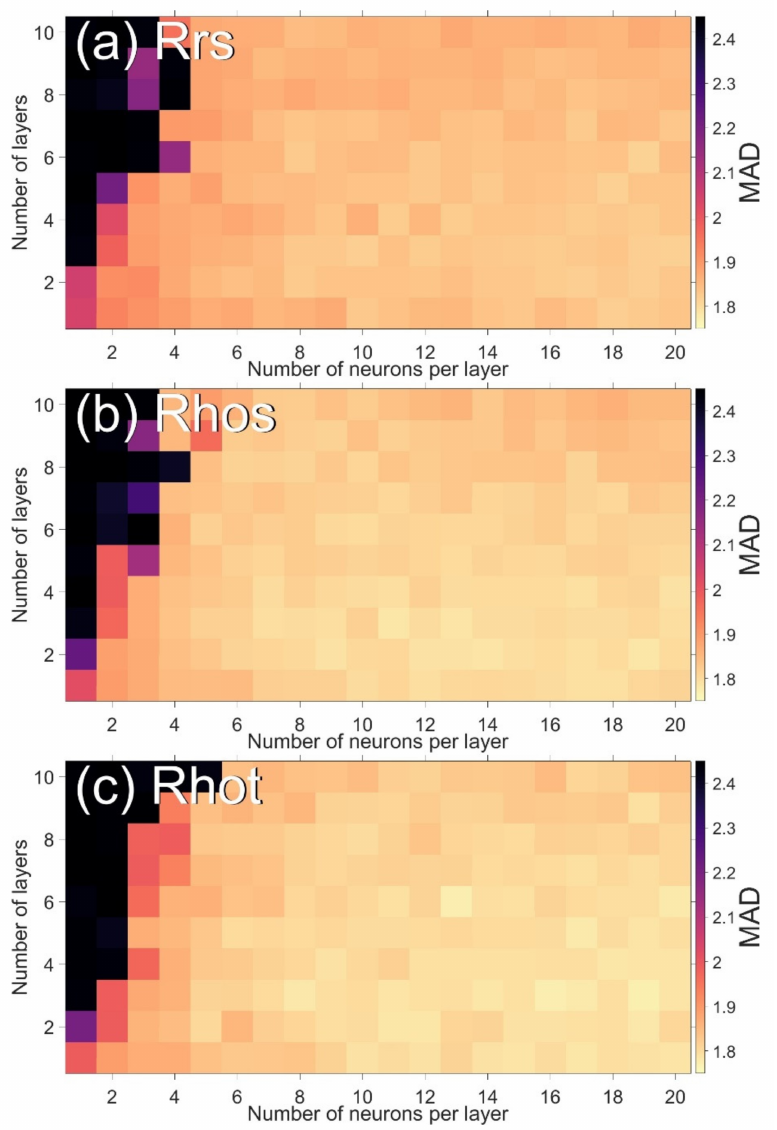
Figure 3. Mean absolute difference heat maps applied to the test set for neural networks operating on Rrs ( a ), Rhos ( b ) and Rhot ( c